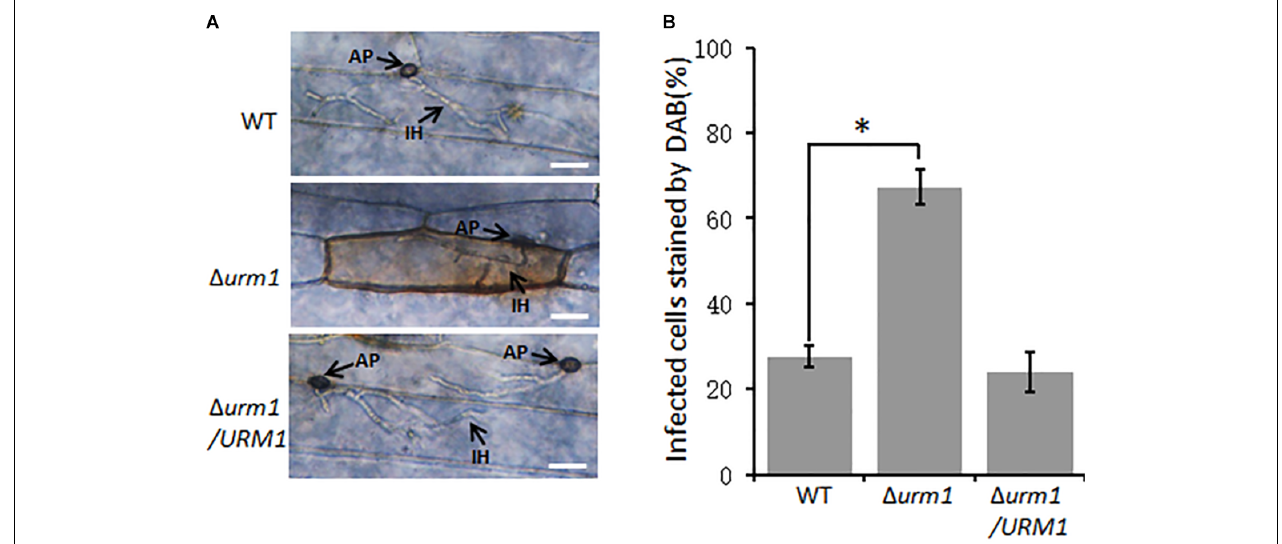
FIGURE 7 | DAB staining assays of the wild type, (cid:49) urm1 mutant and complemented strains penetrated barley epidermis ( Hordeum vulgare cv. E9). (A) DAB sraining assay. Barley epidermis was stained with DAB at 30 hpi. AP, appressoria; IH, infection hyphae. Bar, 20 µ m. (B) Percentage of the infected cells stained by DAB. Significant differences were indicated by asterisks ( P <